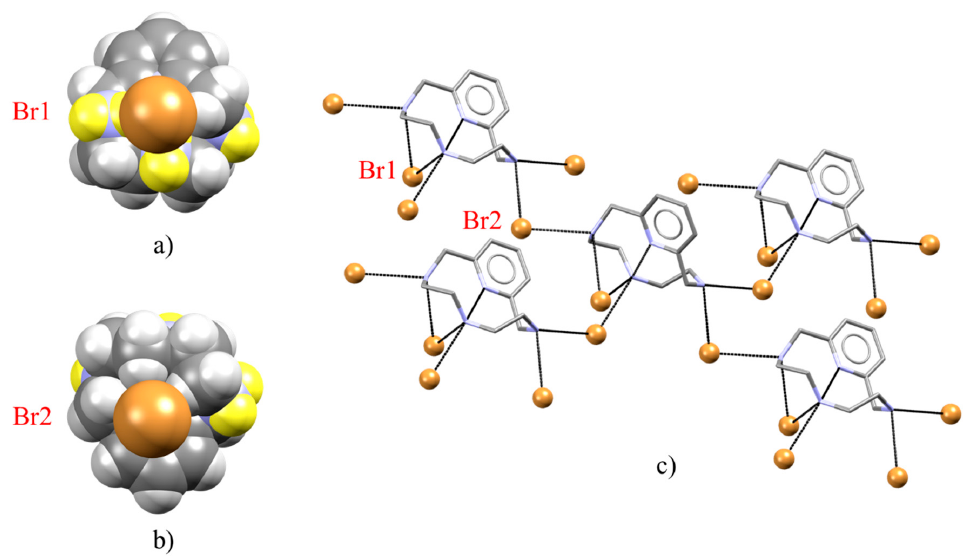
Figure 2. Summary of the crystallographic results presented in [22] (CSD refcode SIBHOC) as functional to current discussion. Color code: white, H; grey, C; cyan, N; brown, Br; H belonging to ammonium groups are highlighted in yellow. ( a ) Detail of the H 3 L1 3+ –Br1 interaction showing the ligand steric impossibility to bring all its ammonium groups towards the anion; ( b ) the other face of H 3 L1 3+ interacting only via C–H anion contacts with Br2; ( c ) the 3-dimensional hydrogen bond network (in black) as found in the [H 3 L1(Br) 3 ] salt.